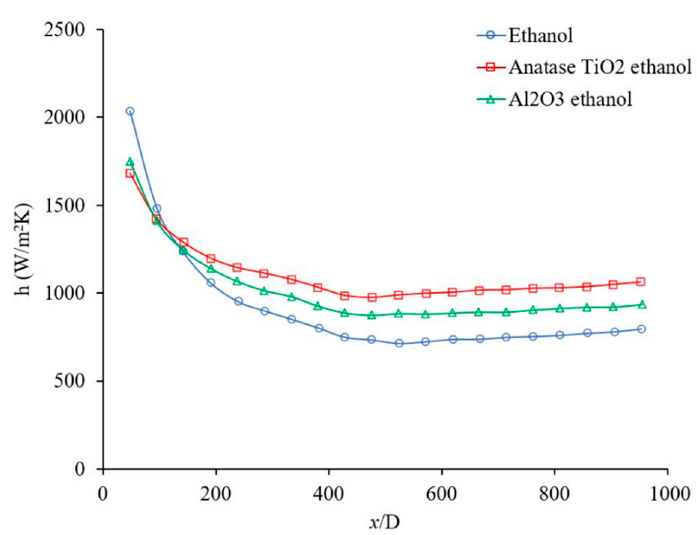
Figure 12. Variation of the heat transfer coefficient as a function of distance for Al2O3–ethanol and TiO2–ethanol nanofluids. Nanofluid concentration was 1 (cid:1875)(cid:1872) % , and the range of Reynolds number inside the microchannel was 150–200. The Al 2 O 3 and Anatase TiO 2 nanoparticles were